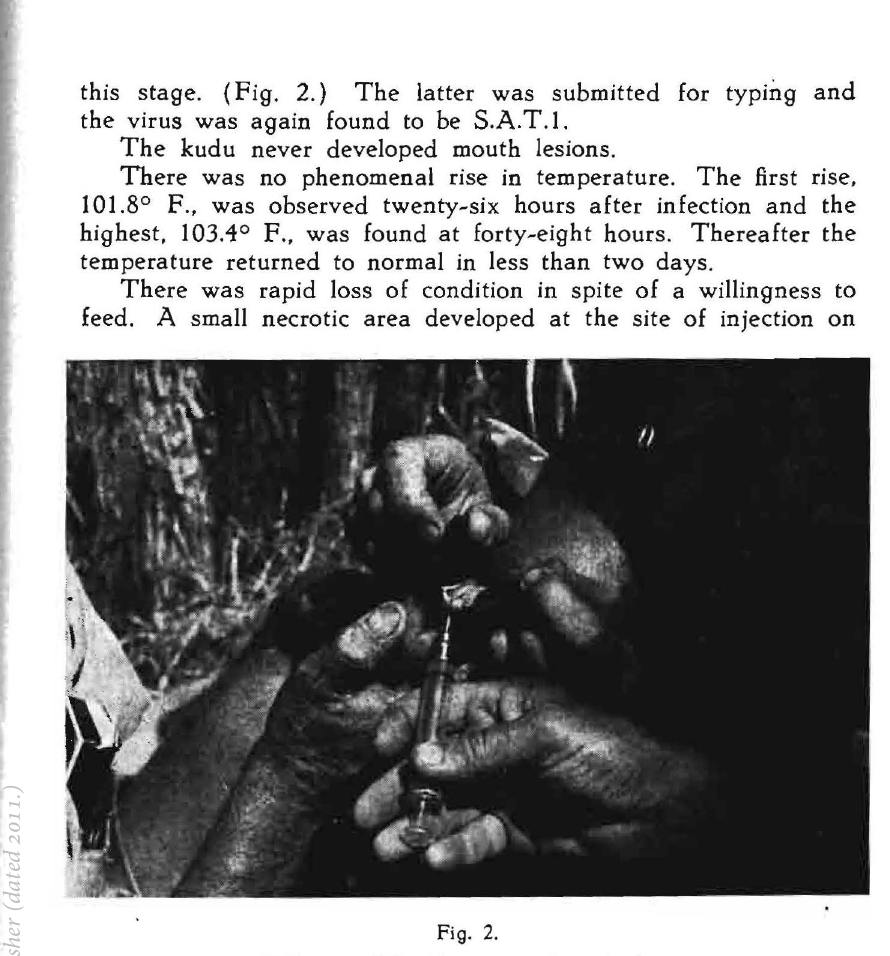
Collection of fluid from a vesicle in the